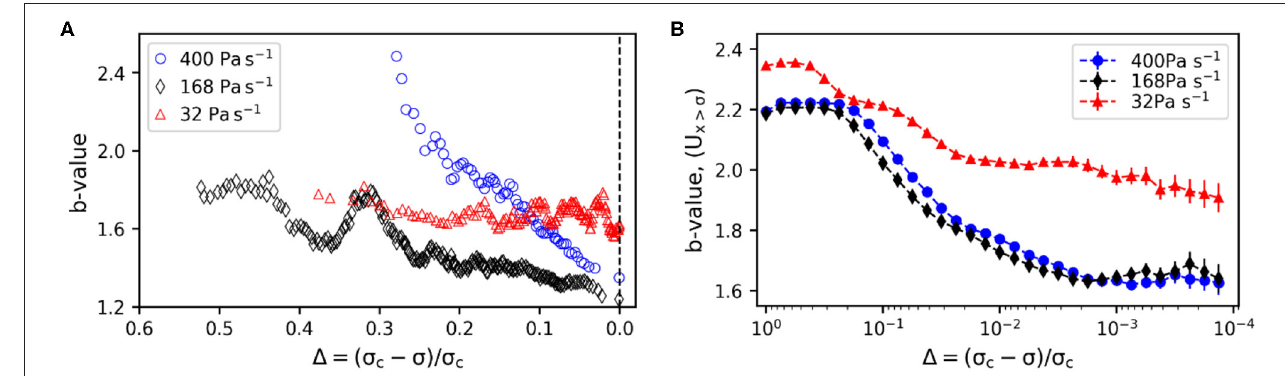
FIGURE 10 | Evolution of b -value with increasing load σ up to failure at σ c for three different loading rates for: the AE energy E AE (A) and the FBM burst elastic energy U (B). Adapted from